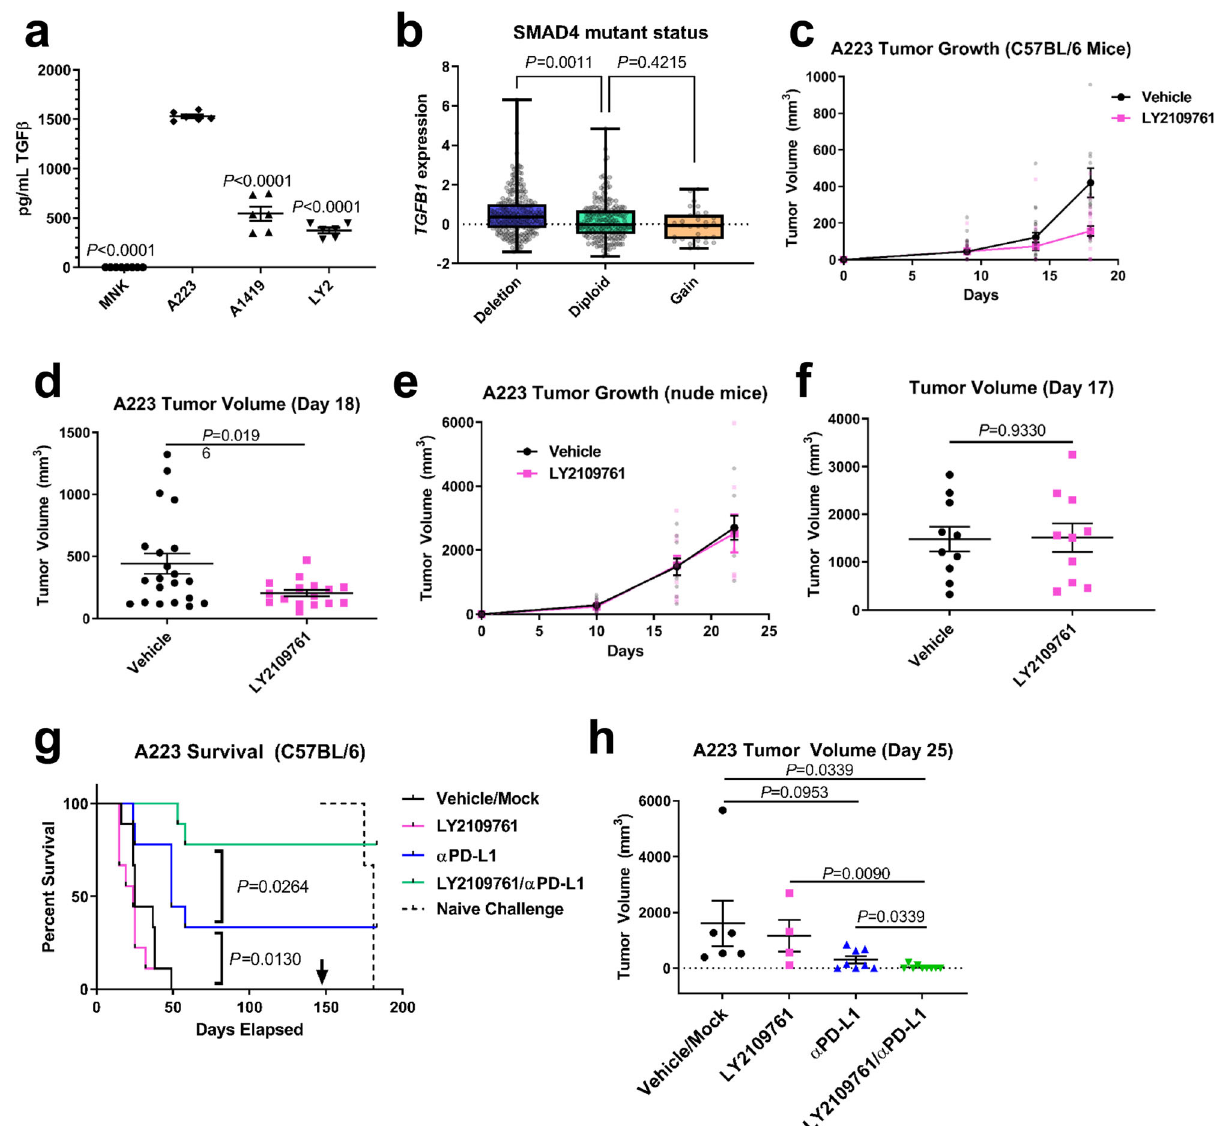
Fig. 1 Smad4-mutant SCCs in mice and humans exhibit high TGF β expression, and combined TGF β inhibition and PD-L1 blockade durably eradicate Smad4-mutant (A223) SCCs. a pg/mL per cell of secreted TGF β measured by ELISA in untransformed mouse skin keratinocytes, A223 cells, LY2 cells, and A1419 cells ( n = 6). P values are shown for multiple comparisons to A223 cells by one-way ANOVA ( F = 328.8, df = 25). b TGFB1 mRNA expression z - scores in human HNSCC patient samples based on their SMAD4 mutant status of deleted (blue, n = 253), diploid (green, n = 205), or gained (orange, n = 30) . P values are shown for multiple comparisons to diploid cells by one-way ANOVA ( F = 8.445, df = 487). c Post-transplant tumor volume of A223 tumors in C57BL/6 mice treated with either 75 mg/kg LY2109761 p.o. per day (pink, n = 22), or carboxymethylcellulose vehicle control (black, n = 22) for 14 days. d Tumor volume on day 18 post-transplant of mice in ( c ). e Post-transplant tumor volume of A223 in athymic nude mice treated as in ( c ) ( n = 10 per treatment group). f Tumor volume on day 17 post-transplant of mice in ( e ). g Survival post-injection of C57BL/6 mice bearing A223 tumors that were treated as in ( c ), with the addition of 200 μ g anti-PD-L1 or its isotype control 3×/week for 2 weeks (vehicle/mock: black lines, LY2109761/mock: pink lines, vehicle/anti-PD-L1: blue lines, LY2109761/anti-PD-L1: green lines, n = 9 per treatment group); surviving mice (combination-treated n = 7, anti-PD-L1- treated n = 3) were rechallenged with A223 cells on day 147 (arrow) along with a cohort of naïve mice (dashed line, n = 5). h Tumor volume on day 25 post-transplant in mice from ( g ). Multiple comparisons were corrected with Tukey ’ s method for ( a ) and ( b ). Unpaired two-tailed t tests were performed for ( d ), ( f ), and ( h ), and survival comparisons were performed using the log-rank Mantel – Cox test. All error bars represent the SEM, except for b where the box represents the 25 – 75 th percentile, whiskers represent the full range, and the line represents the median PD-L1, we explored the relationship between TGF β signaling and ( P = 0.0103, n = 4, gating strategy in Supplementary Fig. 2) PD-L1 expression in SCC. In concordance with previous research, (Fig. 2a), and reduced protein expression of Smad4 by siRNA recombinant TGF β induced PD-L1 expression in LY2 cells, a diminished PD-L1 expression in LY2 cells (Supplementary murine model of carcinogen-induced HNSCC with an intact Fig. 3a, b). This suggests that the TGF β -induced expression of TGF β signaling pathway, in a Smad4-dependent manner. The PD-L1 on LY2 tumor cells is dependent on Smad4-mediated addition of recombinant TGF β to the growth media in vitro canonical TGF β signaling. However, A223 cells lacked PD-L1 signi fi cantly increased PD-L1 surface protein expression expression in vitro both innately and in response to TGF β